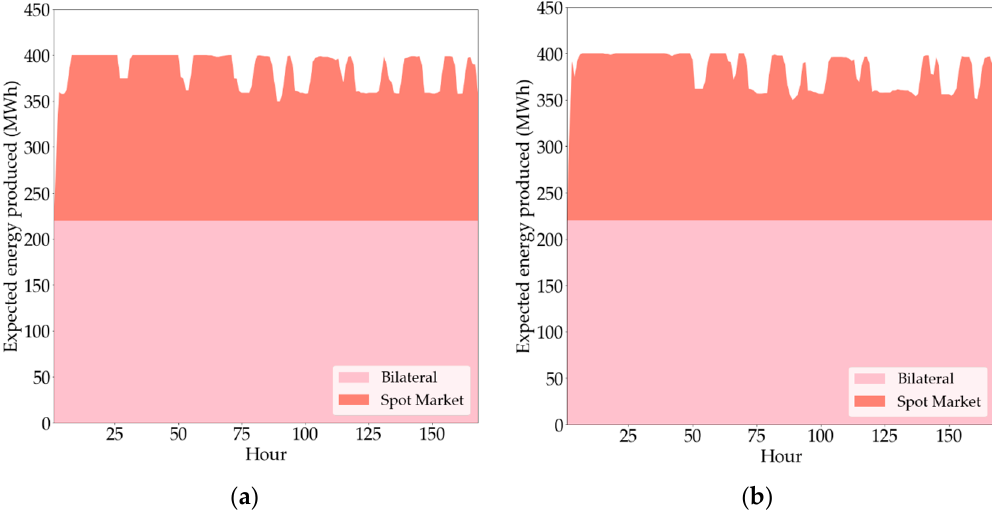
Figure 16. The expected energy produced, ( a ) with gas storage, and ( b ) without gas